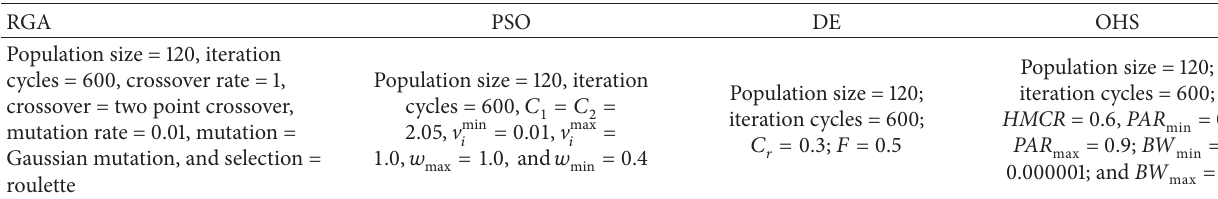
Table 1: Control parameters of RGA, PSO, DE and OHS.